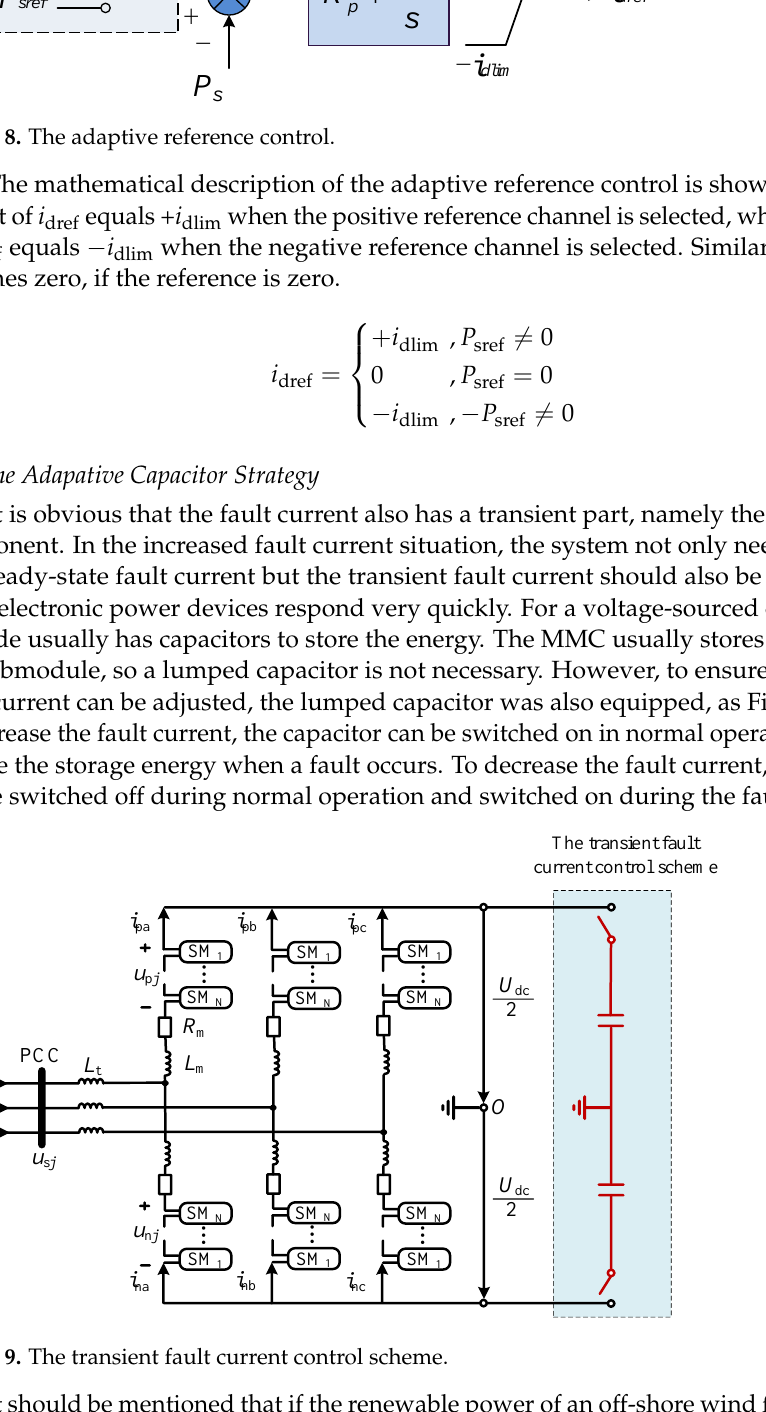
Figure 10. The test system of the two-terminal HVDC. Table 1. The control modes of each converter. Control Strategy